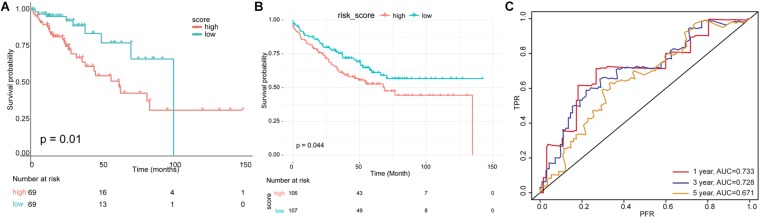
Evaluation of multivariate prognostic model. (A) A risk model was constructed using 19 immune-related factors, and the test set was divided into high- and low-risk groups according to scoring values. (B) The survival analysis for independent validation dataset. (C) The receiver operating characteristic (ROC) curve and area under the curve (AUC) value of survival time were predicted by multivariate risk model.